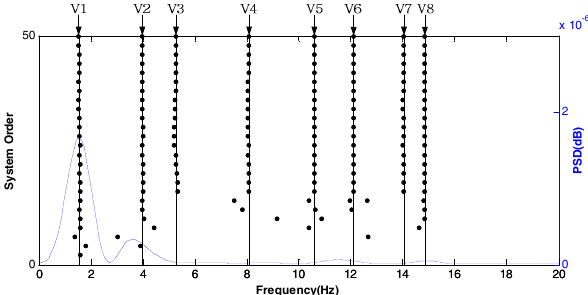
Figure 5. Stabilization diagram in the X direction of test point 1 under normal conditions.